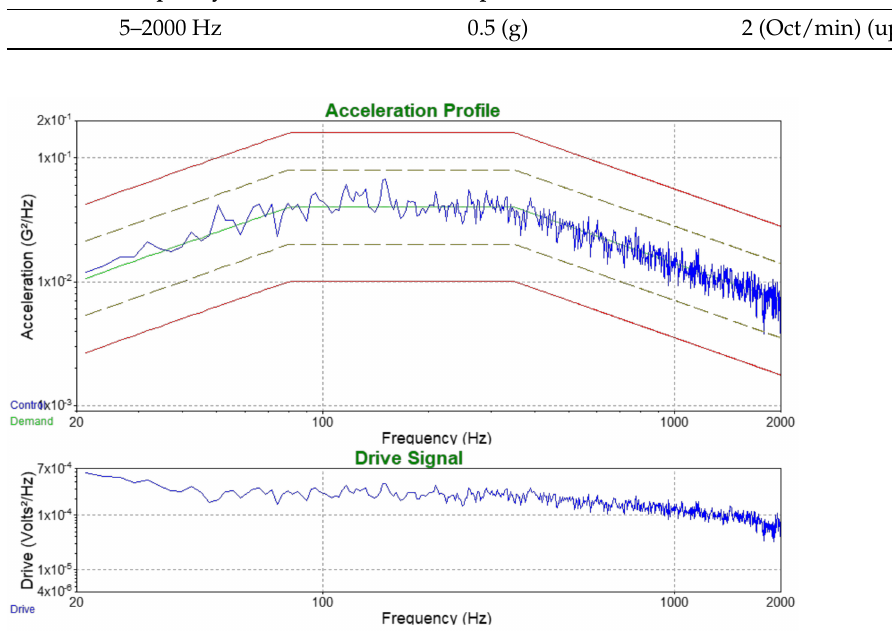
Figure 15. Acceleration profile and Output drive for the applied random vibrations.